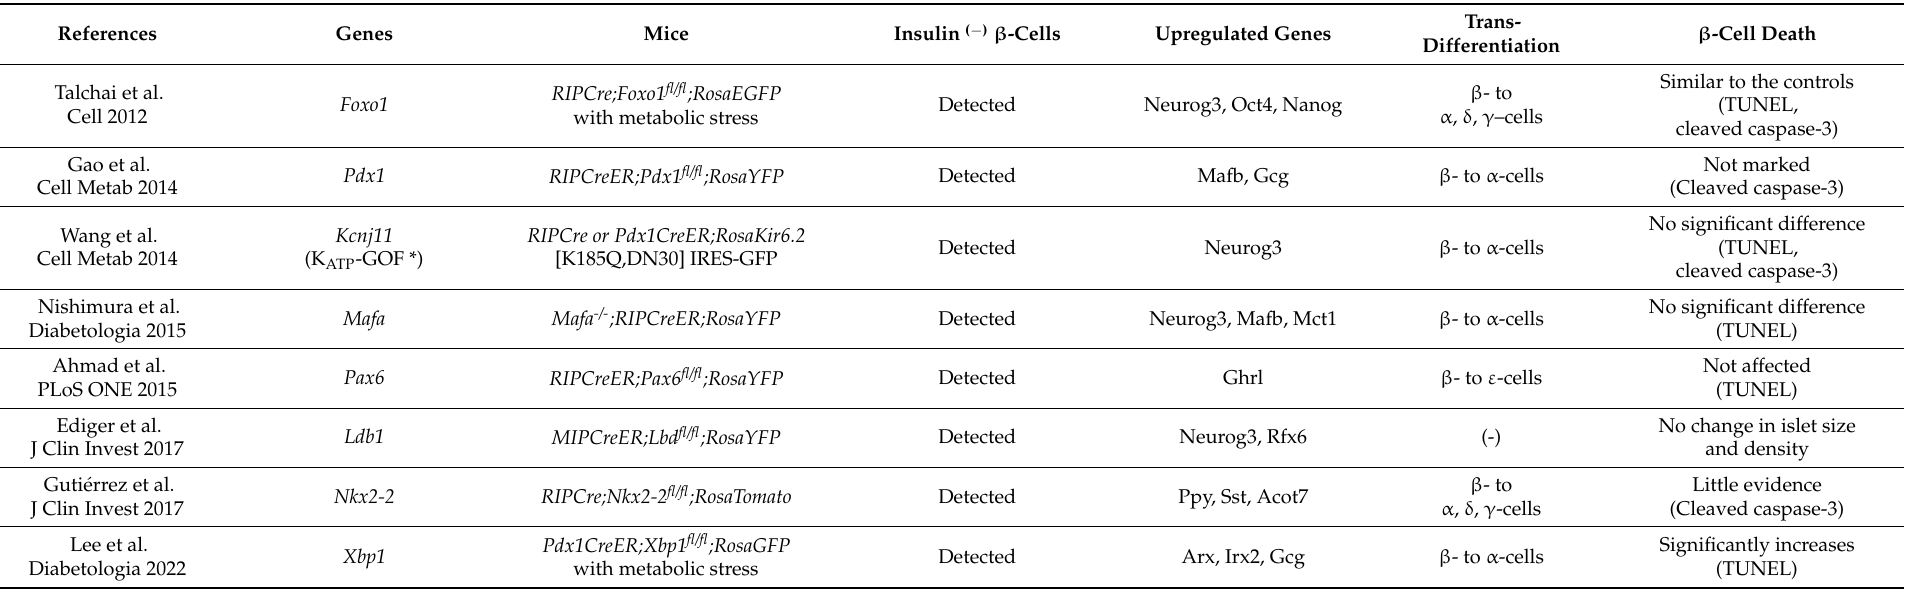
Table 1. Genetic lineage tracing studies of transgenic mice to show adult β -cell